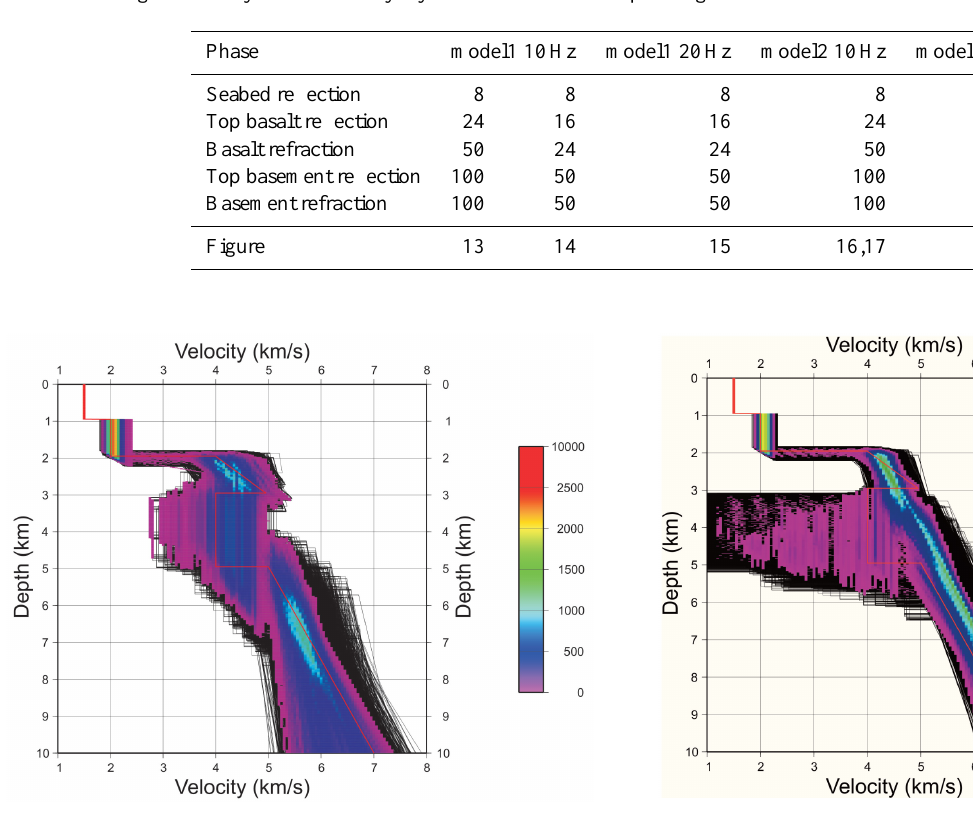
Fig. 14. Results obtained after using the Metropolis algorithm on data from model 1 and 10Hz for 40000 cases. Uncertainties were reduced in comparison with the previous case (Fig. 13). Red line represents the real model and every black line a modified model. The colour scale stands for the number of times that a model (or part of it) is visited. The preferred model consists in a velocity gradient which includes basalt, and basement layers, avoiding the need of a low velocity layer under the